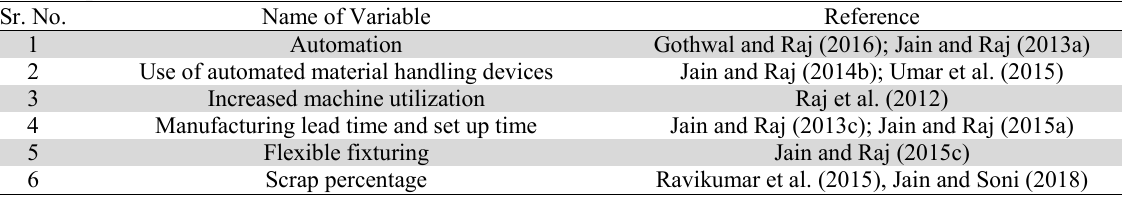
Name of performance variables Sr.